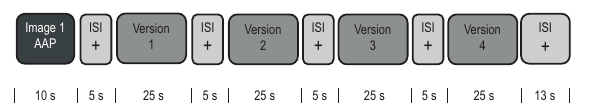
FIGURE 1 | Schematic depiction of a single trial. Each of the eight trials (one for each of the eight scenes) contained four versions of the textual description of the same scene, representing each of the four conditions of the design, defined by the frequency of emotional or abstract words occurring in the